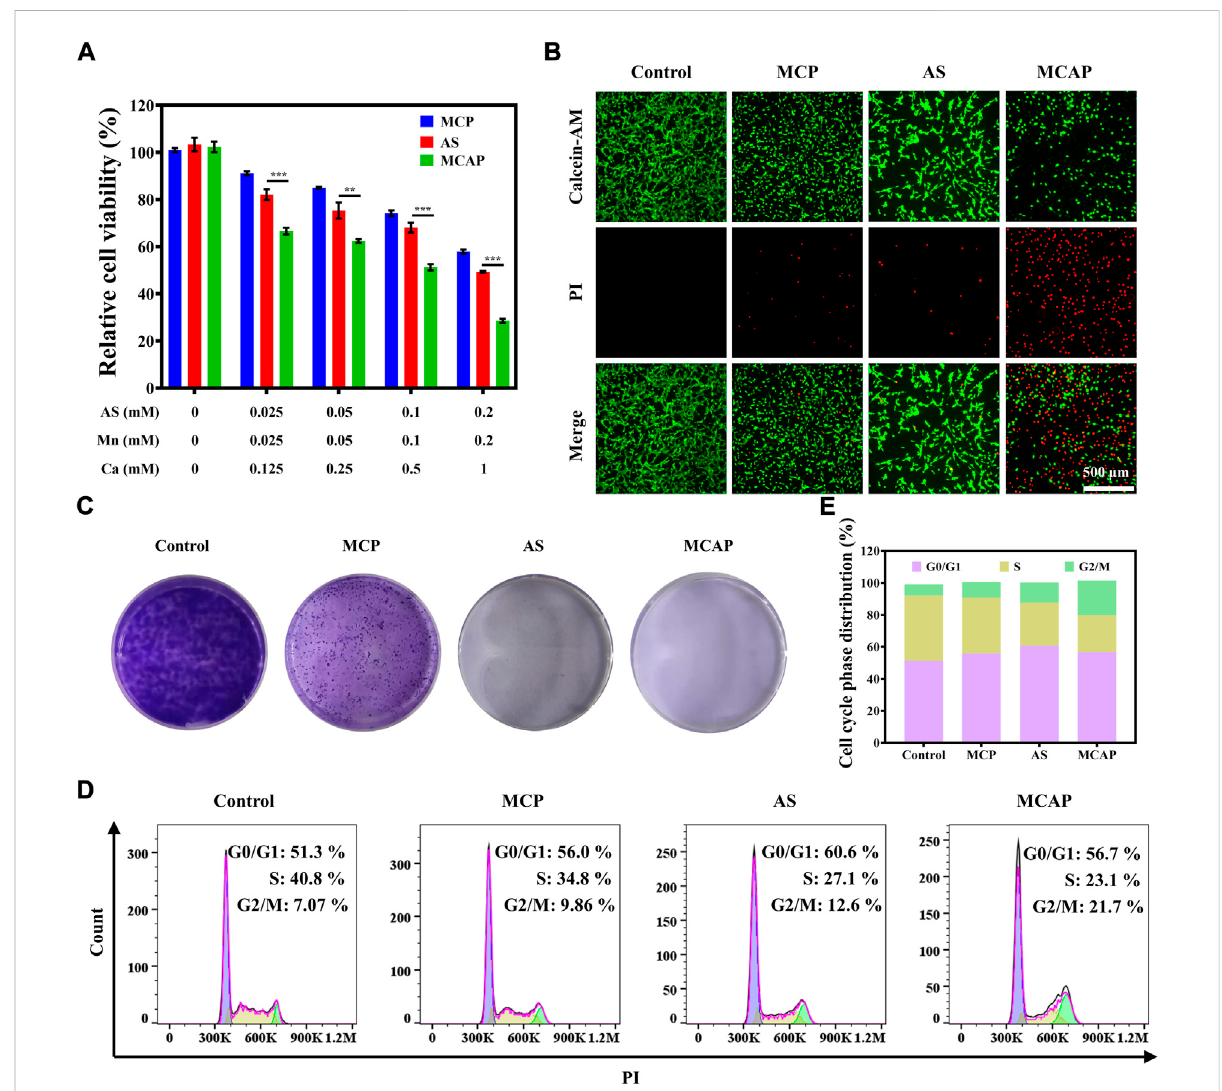
FIGURE 4 Invitro anticancereffectofMCAPNPsonCT26cells. (A) Relativecell viabilityofCT26cellsafter beingtreatedwithAS,MCPNPsandMCAP NPs for 24 h. (B) Fluorescence images of CT26 cells treated with various formulations and stained with Calcein-AM (live cells: green color) and PI (dead cells: red color). (C) The colony formation of CT26 cells after various treatments. (D) . (E) Flow cytometry analysis of cell cycle phase distribution of CT26 cells after various treatments (*** p < 0.001, ** p < 0.01, * p <